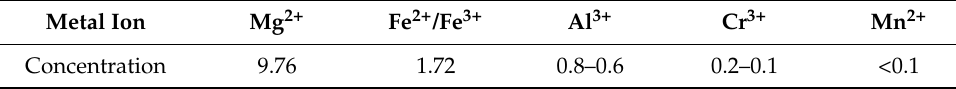
Table 6. Metal ion concentrations in leachates (g/L).